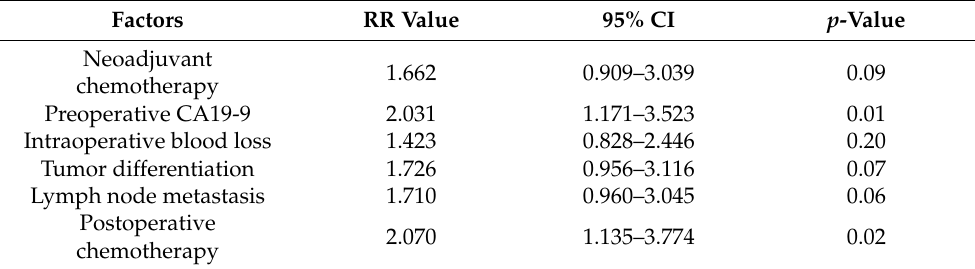
Table 4. Multivariate analysis of long-term survival in patients with